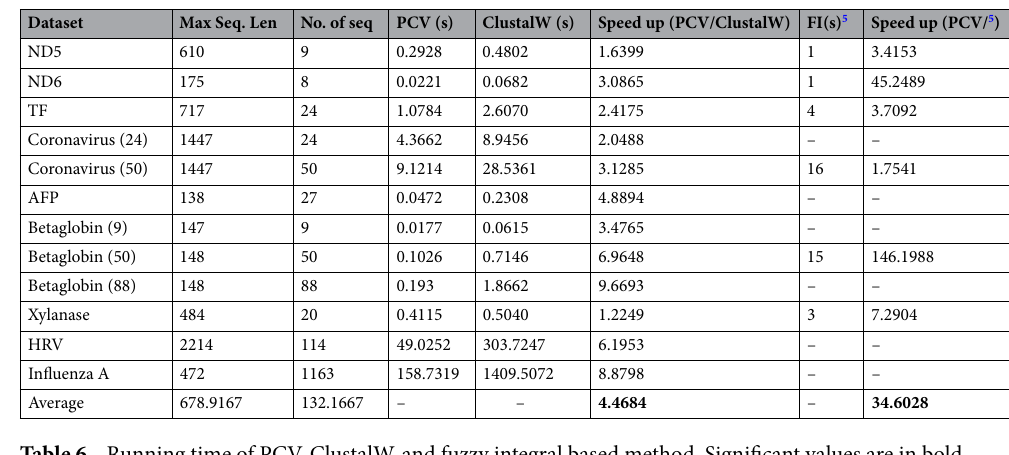
Table 6. Running time of PCV, ClustalW, and fuzzy integral based method. Significant values are in bold.